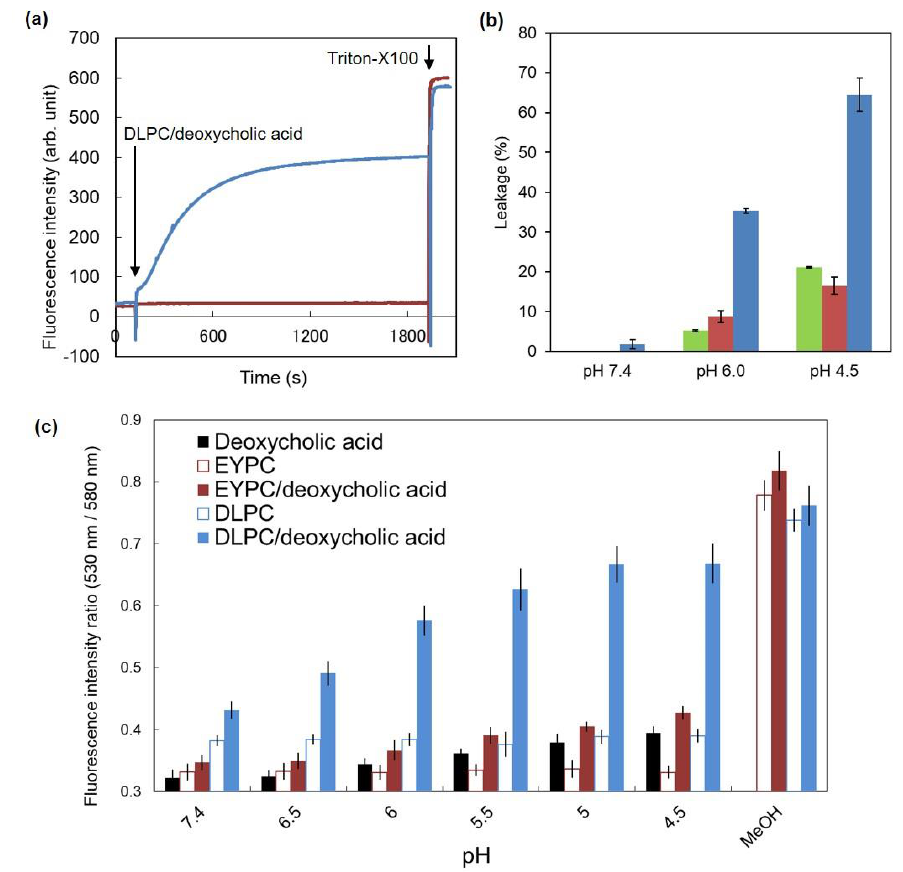
Figure 2. pH-responsive properties of DLPC/deoxycholic acid micelles. ( a ) Time courses of pyranine fluorescence for pyranine-loaded EYPC liposomes after addition of DLPC/deoxycholic acid micelles at pH 7.4 (red) or 5.0 (blue). Triton-X100 was added to dissociate the liposomal membrane completely. ( b ) Comparison of membrane disruptive activity for pyranine-loaded EYPC liposomes by addition of DOPE/CHEMS (green), DOPE/oleic acid (red) and DLPC/deoxycholic acid micelles (blue) at various pH. ( c ) Lipid mixing assay using EYPC liposomes containing Rh-PE/NBD-PE and various vehicles. Ratios of fluorescence intensity at 530 nm and 580 nm, which indicate a decrease of FRET by lipid mixing, are shown as a function of pH. Methanol was used to achieve complete lipid mixing.